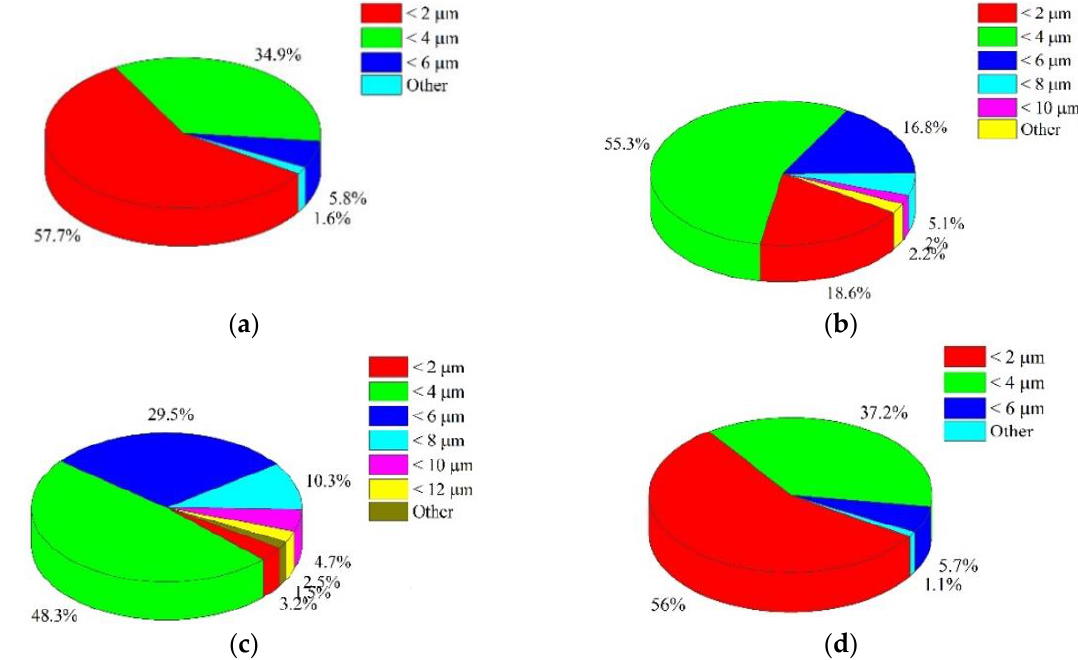
Figure 3. Specific distribution of dimensions of dimples found on the fracture surface of specimens from the VT23M alloy with the following magnifications: ( a ) x3000; ( b ) x1200; ( c ) x800; ( d ) x 200.